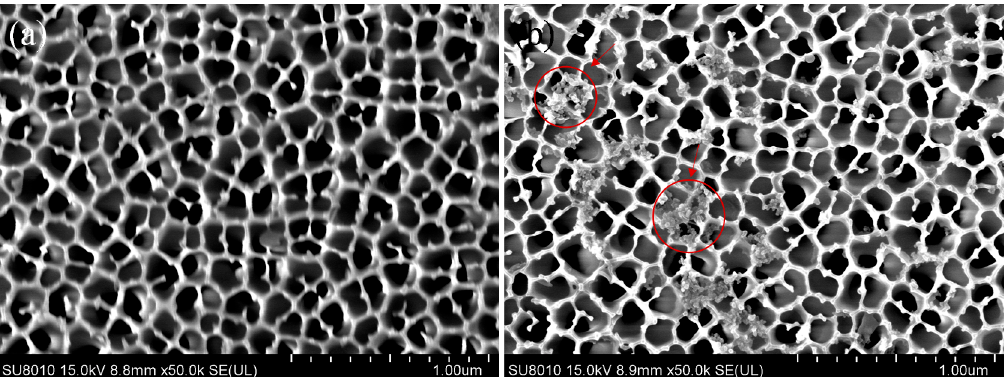
Figure 3. SEM images of nanoporous alumina membranes without 8-OHdG captured ( a ) and with 8-OHdG captured on nanoporous alumina membranes ( b ).